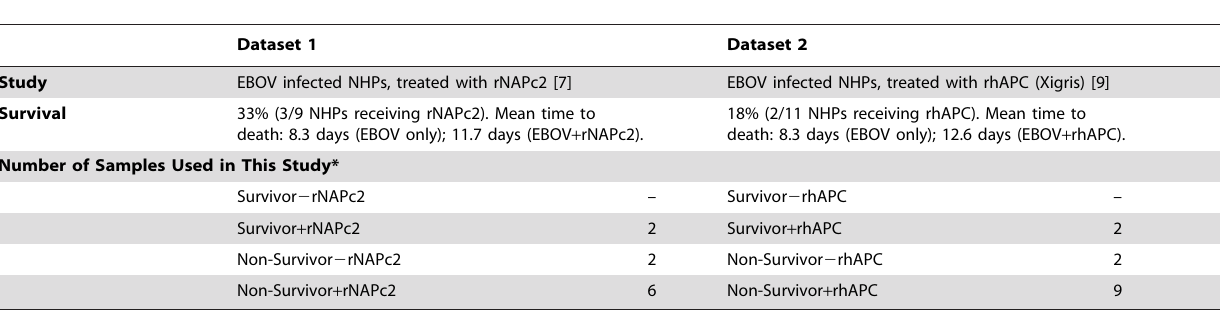
Table 1. Summary of methods and results from previous